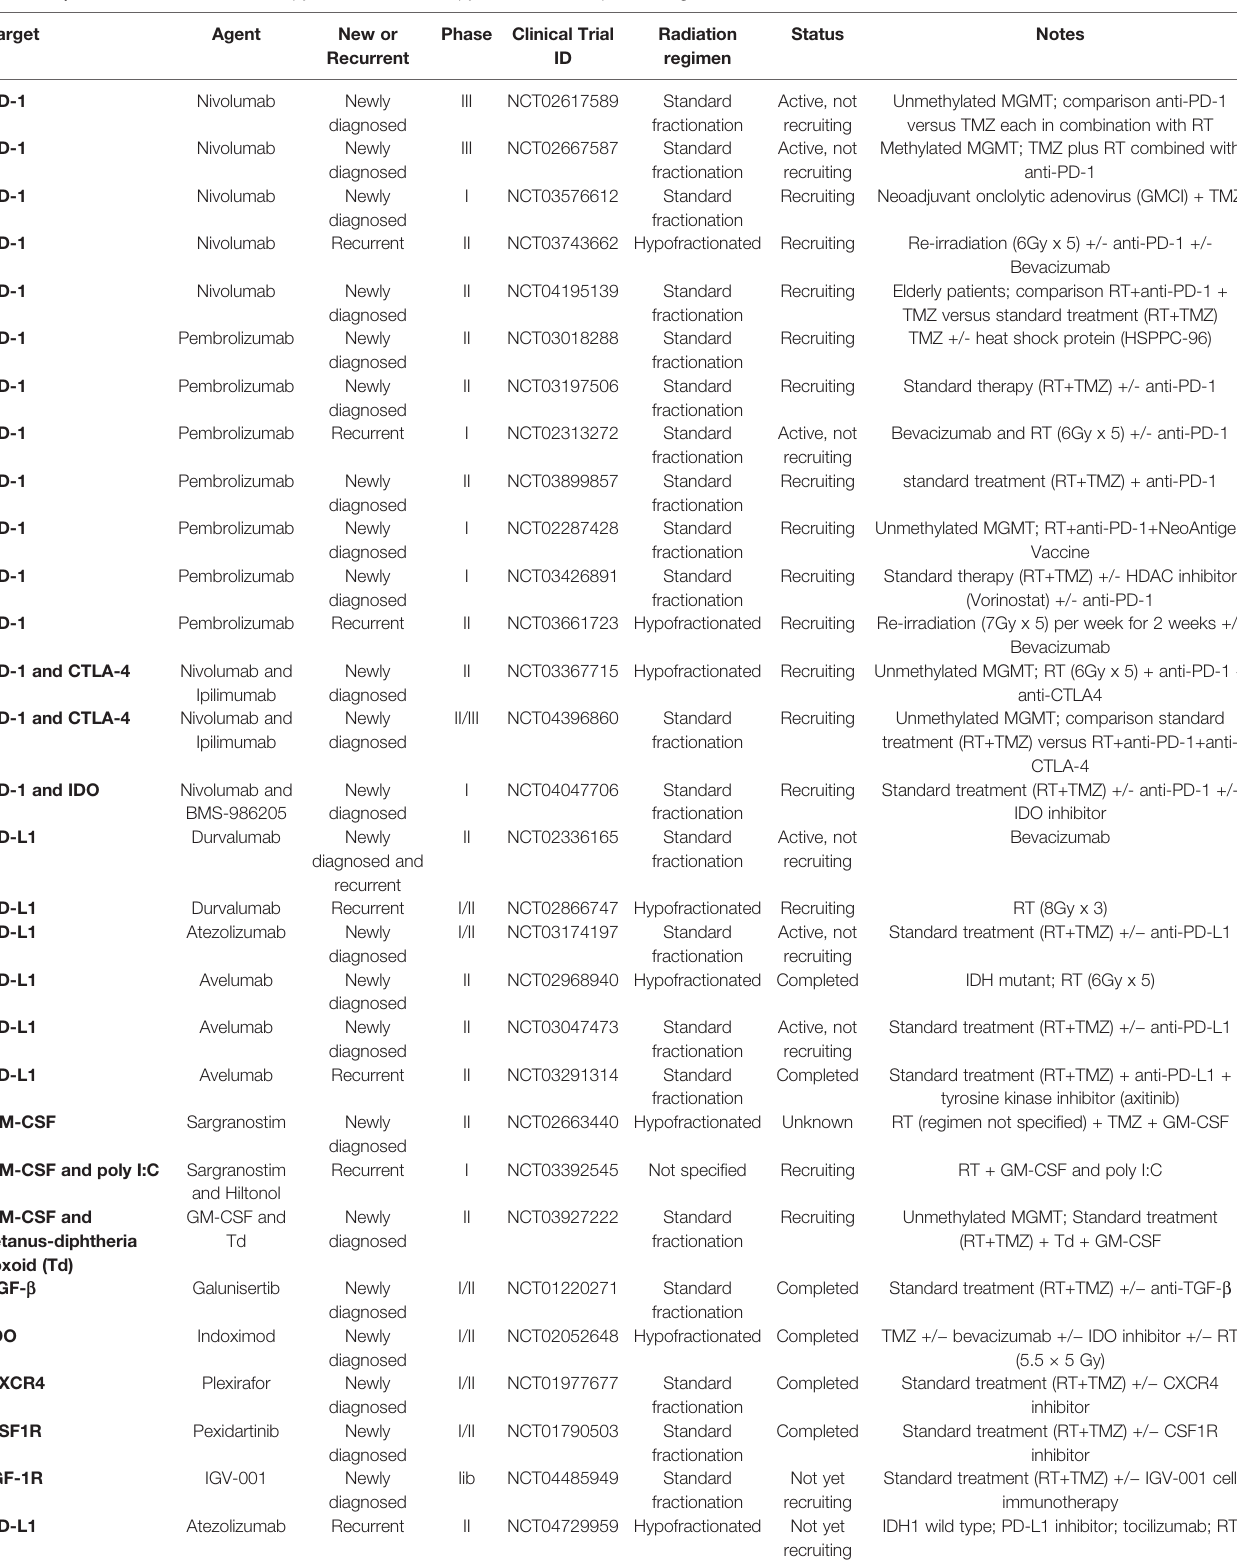
TABLE 1 | Combination of immunotherapy with radiation therapy in clinical development for